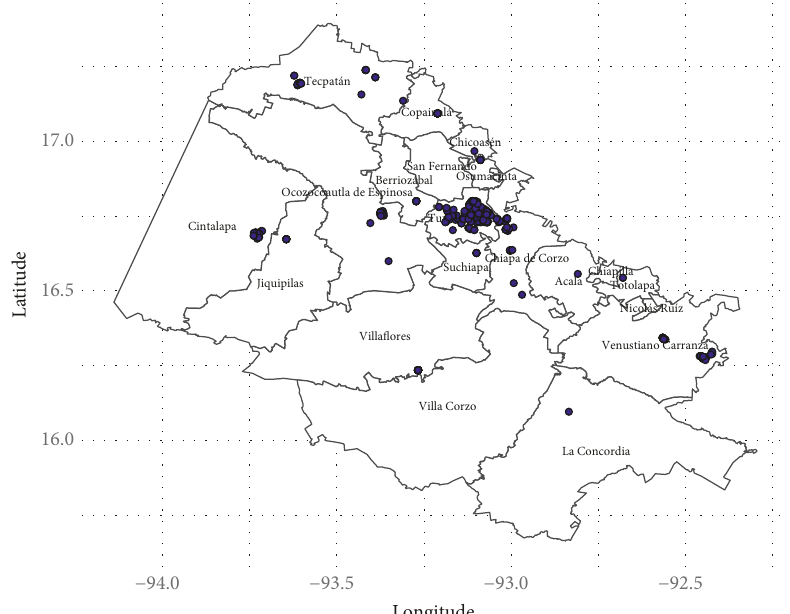
Figure 3: Municipalities of Chiapas with more confirmed cases of